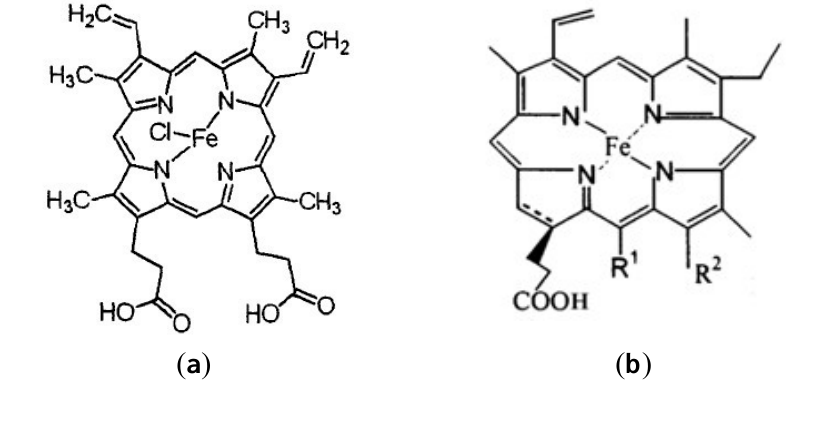
Figure 5. Structure of ( a ) hemin; and ( b ) Fe-chlorophyllin. R 1 = H, CH